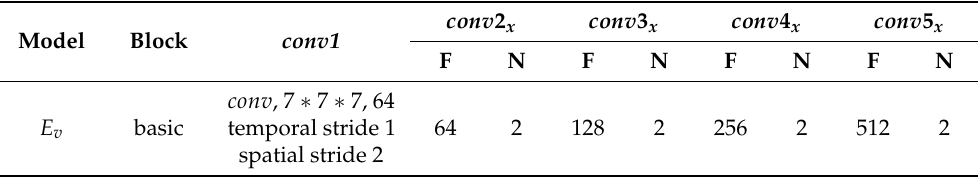
Table 1. Network architectures of the IR video feature extractor E v ; each convolutional layer is followed by batch normalization and a ReLU. (F is the number of the channels, and N is the number of blocks in each layer). conv 2 x conv 3 x conv 4 x Model Block conv1